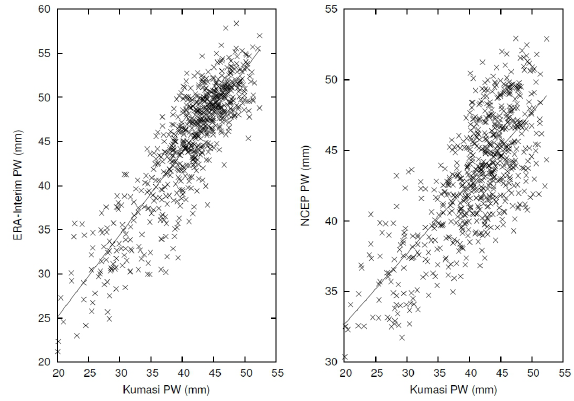
Figure 6: Correlation plots of computed PW for KNUST against